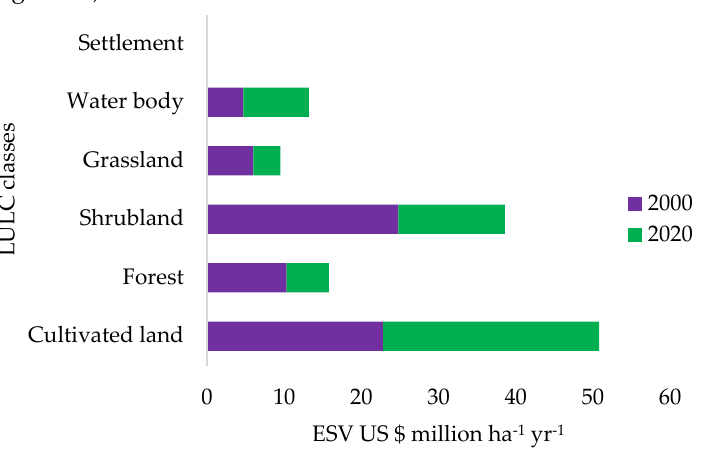
Figure 15. ESV from 2000 to 2020 in Rib watershed, Ethiopia (Source of data: Anley et al. [72], but figure done by authors).